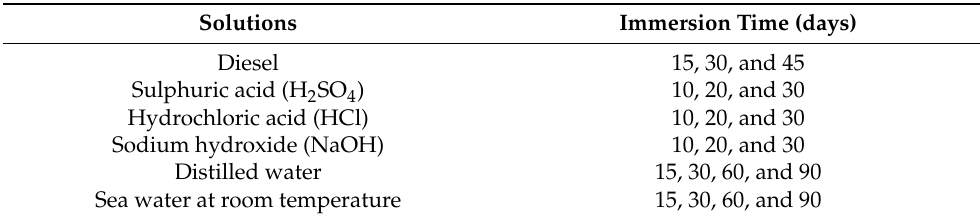
Table 1. Different solutions and immersion times used in this